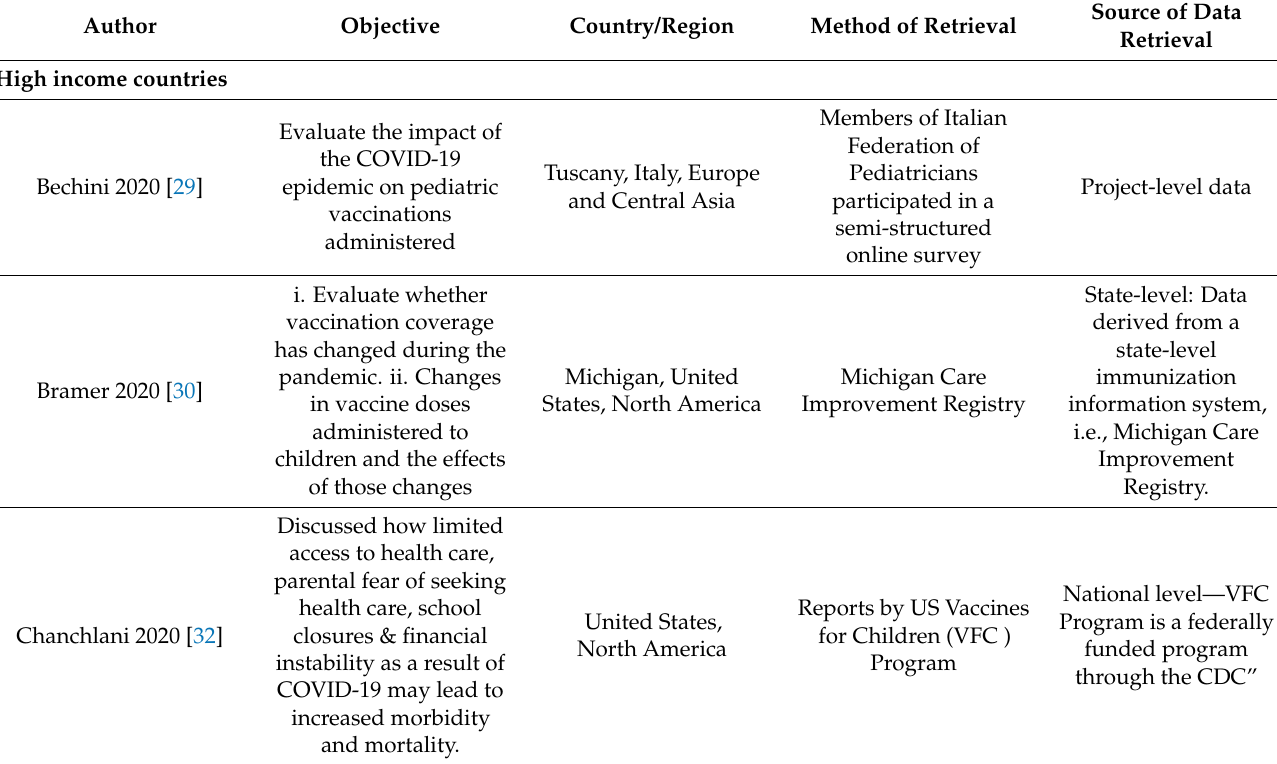
Table 1. Characteristics of studies included.